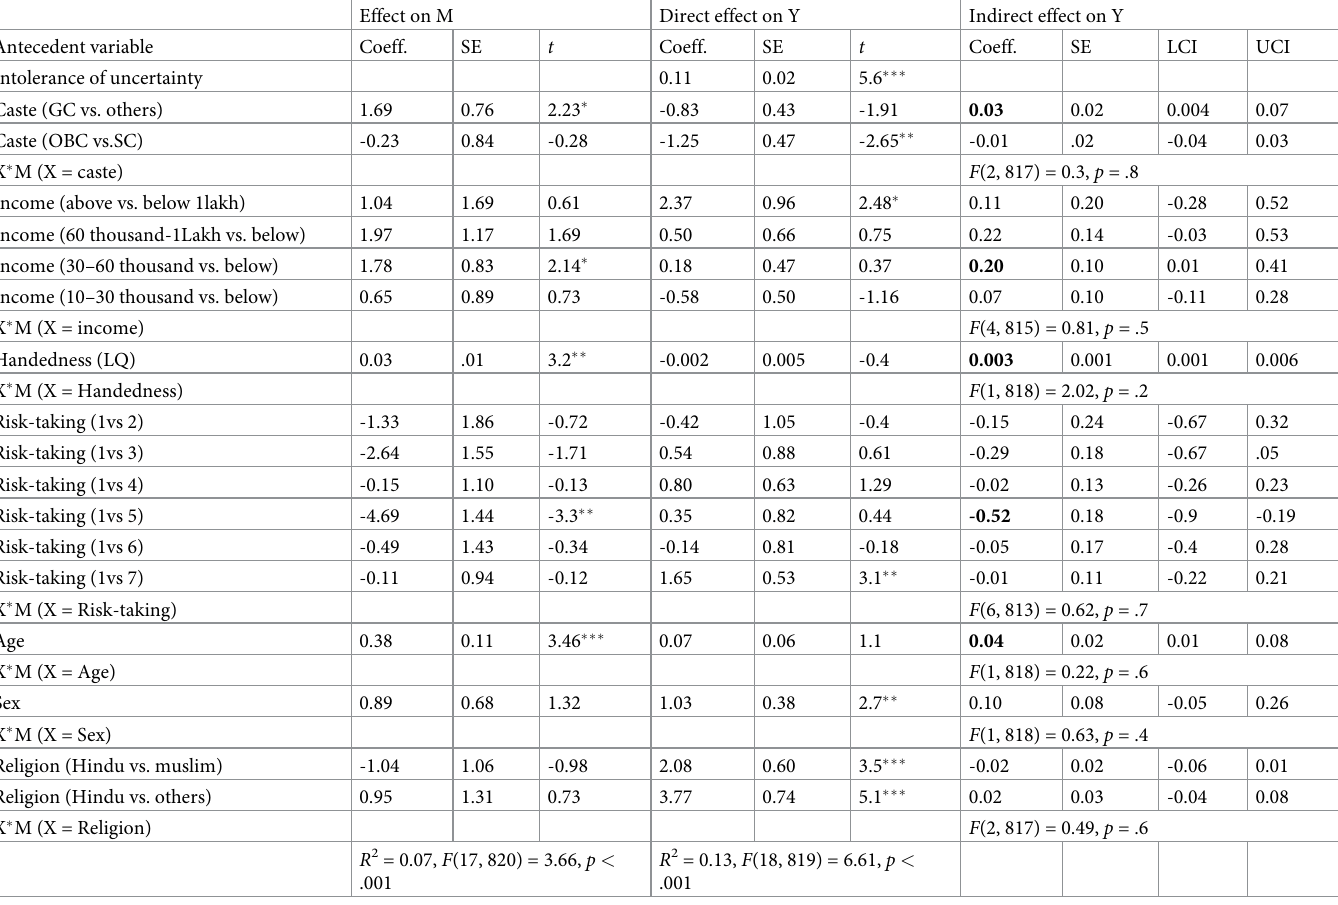
Table 6. The effects (direct and indirect effect) of antecedent and mediation (general IU) variables on behaving in the students’